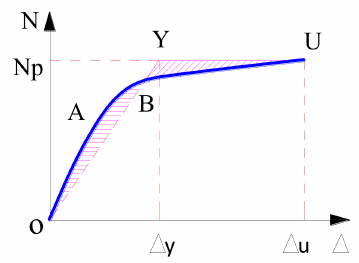
Figure 16. The sketch of energy equivalent method.